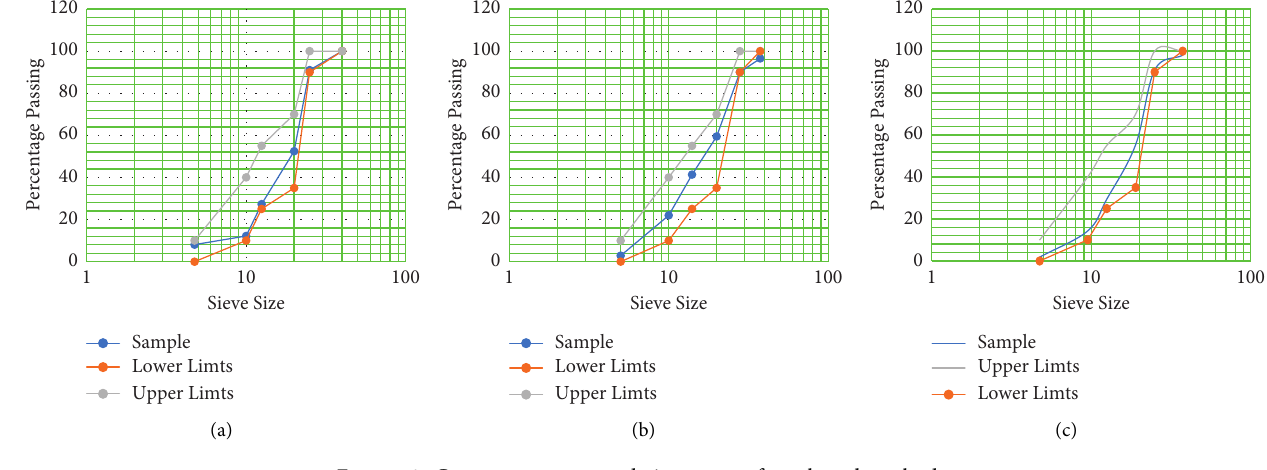
Figure 2: Coarse aggregate gradation curves for selected Table 5: the proportions of concrete ingredients as determined by the ACI, DOE, EBCS, and IS methods.